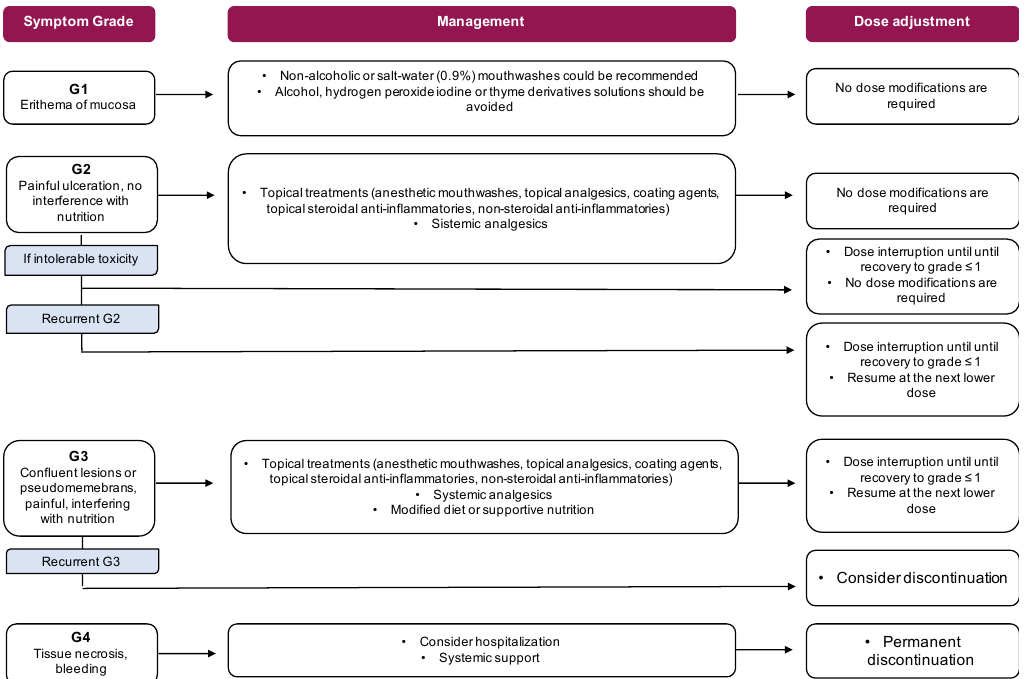
Figure 2. Dose modifications and management of mTOR inhibitors.